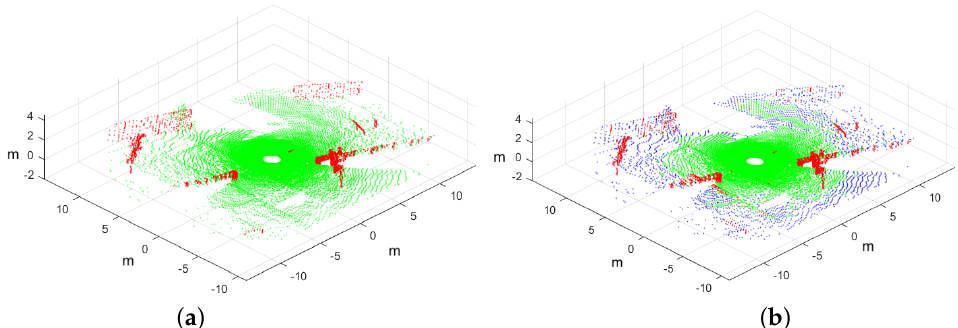
Figure 8. The validation scan on the park ( a ) and the prediction results with RF ( b